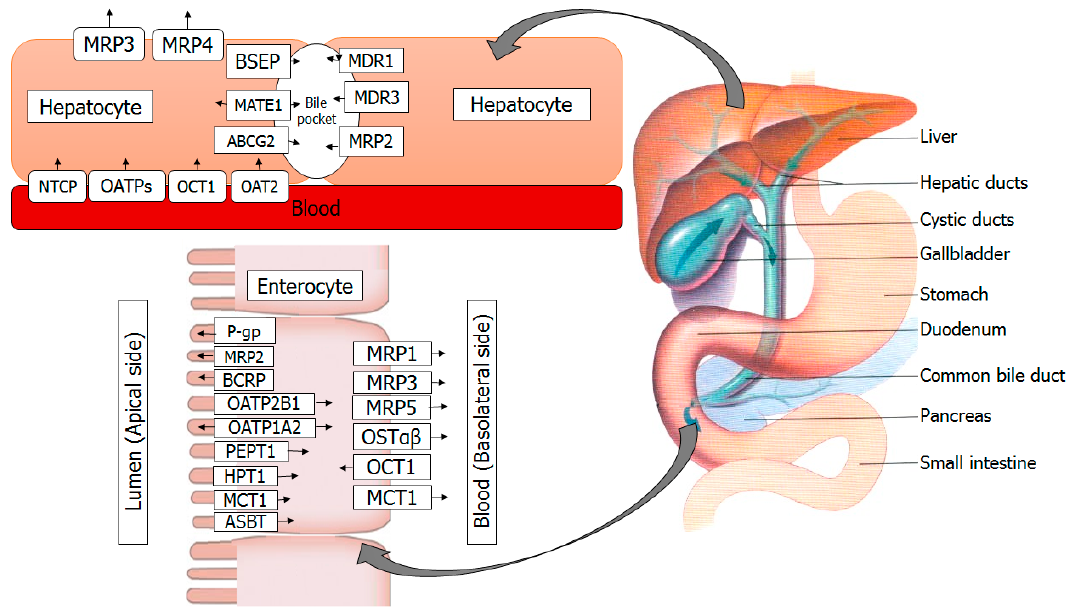
Figure 1. A schematic representation of transporters in human intestine and liver for movement of drugs, botanical supplements and bile